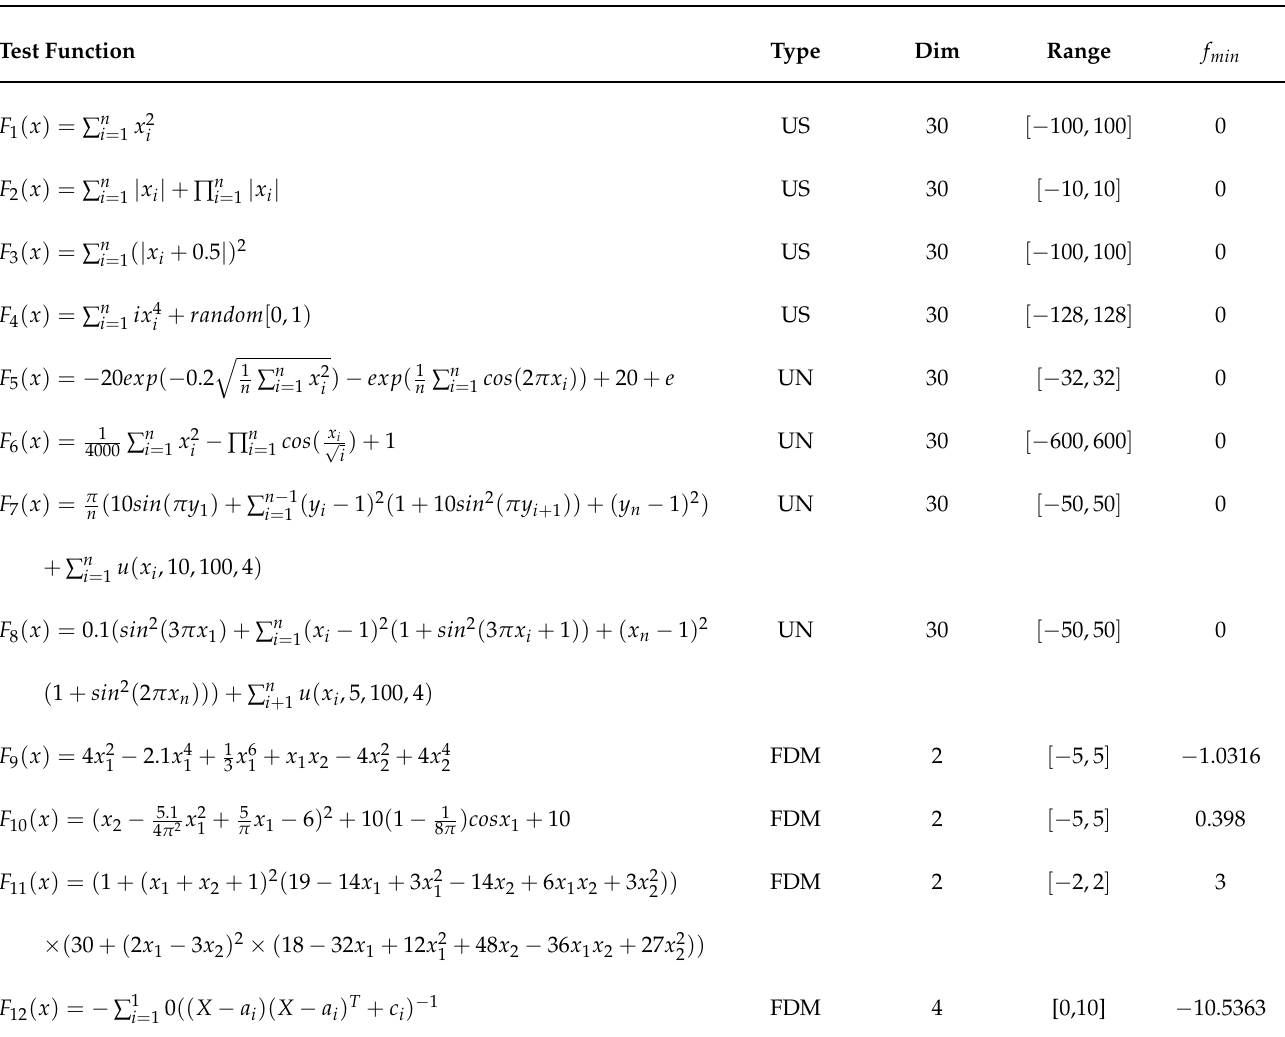
Table 1. Benchmark Function.